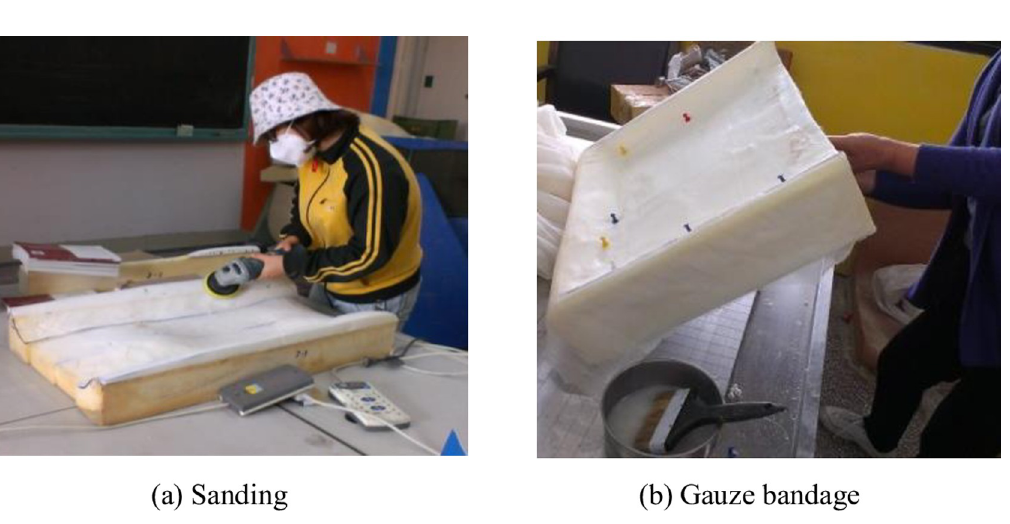
Fig 5. Production process photos. (a) Sanding (b) Gauze